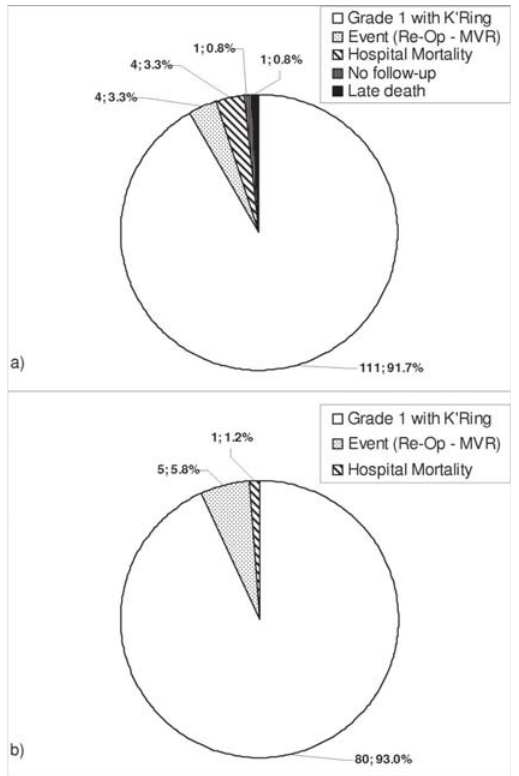
Fig 5 – A: Shows the postoperative outcomes in the adult